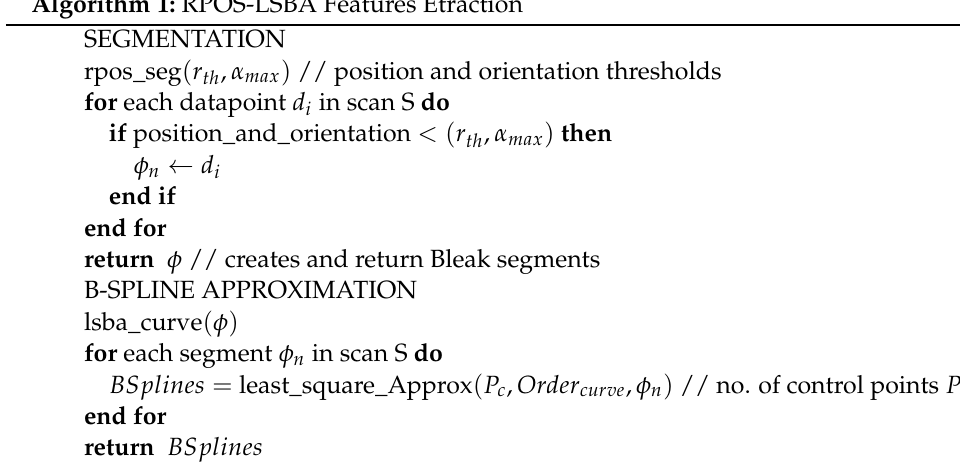
Algorithm 1: RPOS-LSBA Features